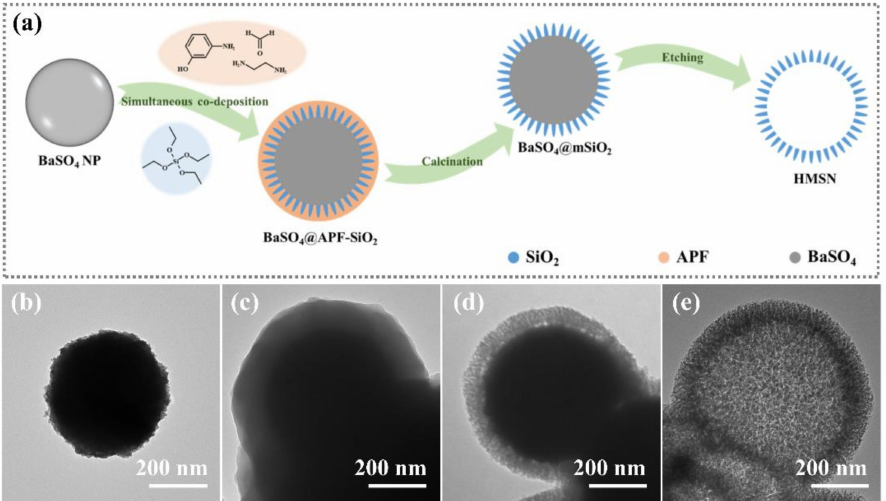
Figure 1. Schematic illustration of the strategy for the preparation of hollow mesoporous silica nanoparticles (HMSN) ( a ); transmission electron microscopy (TEM) images ( b – e ) of BaSO 4